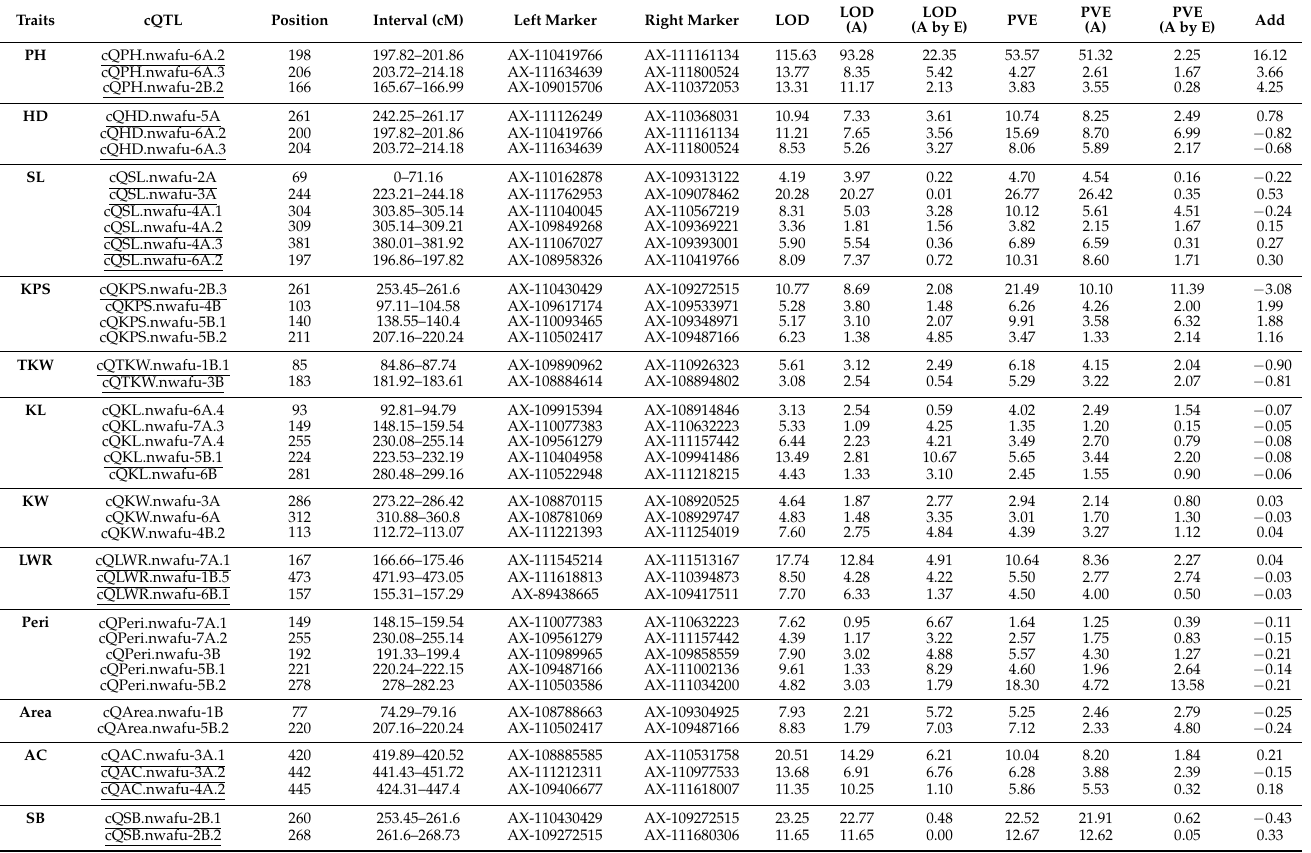
Table 4. Major or stable QTL mapping results of multiple environment